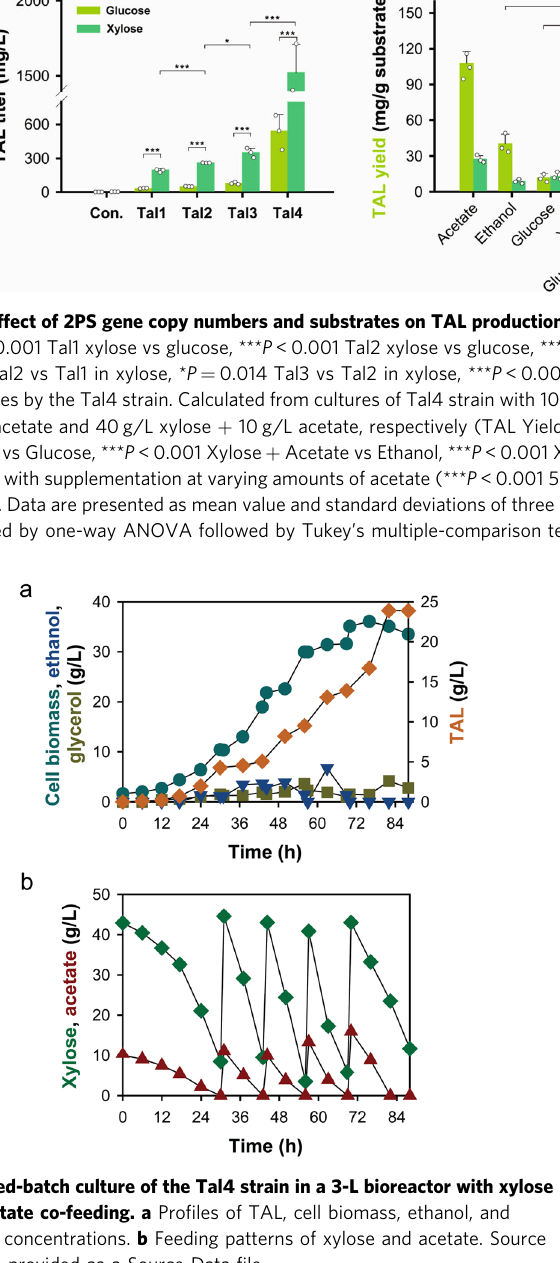
Fig. 6 Production of TAL by the Tal4 strain in hemicellulose fractions of switchgrass hydrolysate. a Pro fi les of TAL, xylose, acetate, and glucose concentrations. b Pro fi les of cell biomass, ethanol, and glycerol concentrations. Data are presented as mean value and standard deviations of three independent biological replicates. Source data are provided as a Source Data fi